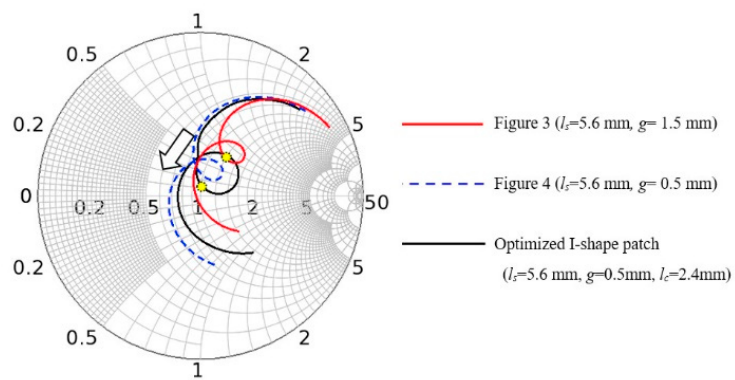
Figure 5. Input impedance optimization after the size of the antenna is changed from rectangular shape (Figure 1b) to I-shape MSA (Figure 1c).